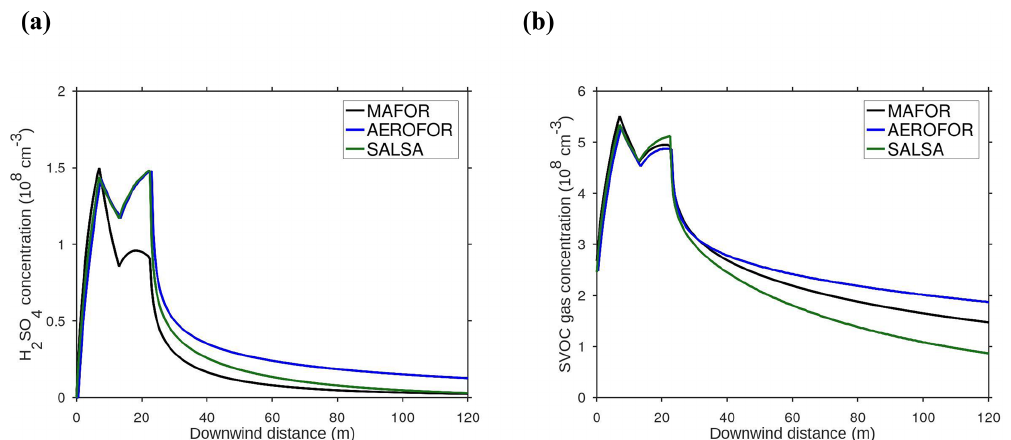
Figure 13. Comparison of modelled gas-phase concentrations as a function of downwind distance in the Urban Case simulation: (a) sulfuric acid and (b) sum of semi-volatile organics (here SVOCs for